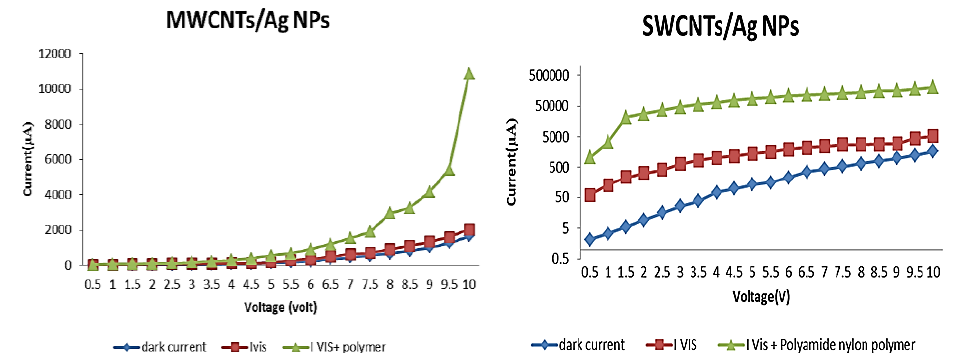
Figure 9b: The variation ofֹ the visible photo-current of the fabricated photoconductive detector with coating polymer for SWCNTs/Ag NPs and MWCNTs/Ag NPs.